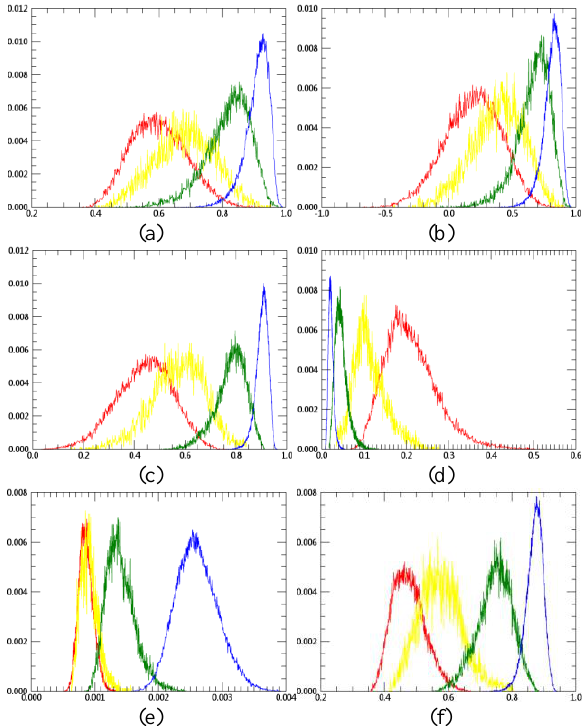
Figure 3. Probability Density Functions of features. (a) Dop ; (b) μ ; (c) A 12 ; (d) Ph ; (e) V ; (f) rrr s